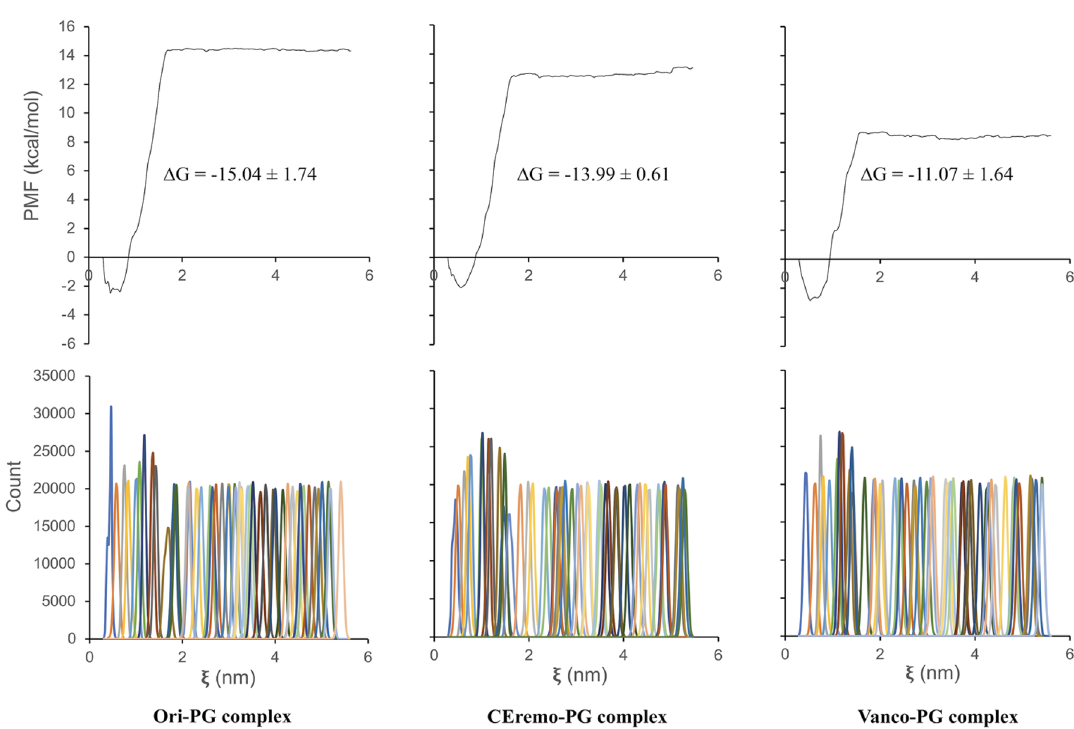
Figure 7. The potential of mean force (PMF) curve and corresponding umbrella histograms for complexes of [ 19 F]oritavancin–PG (left), chloroeremomycin–PG (middle), and vancomycin–PG (right). The ΔG values of the complexes obtained from the PMF curve are shown as an inset. The PMF for the desleucyl-glycopeptide–PG complexes is included in the Supplementary